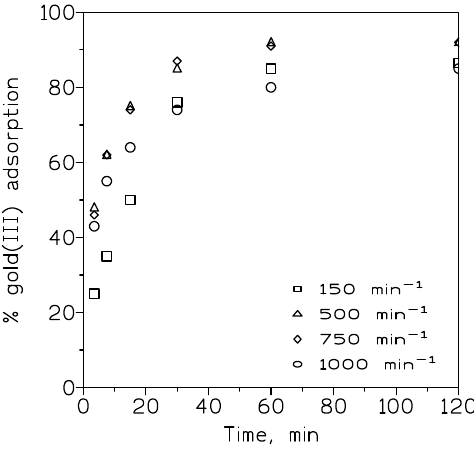
Figure 4. Influence of the stirring speed on gold(III) adsorption. Aqueous solution: 0.005 g L − 1 Au(III) in 0.1 M HCl. Adsorbent dosage: 0.25 g L − 1 . Time: 2 h.